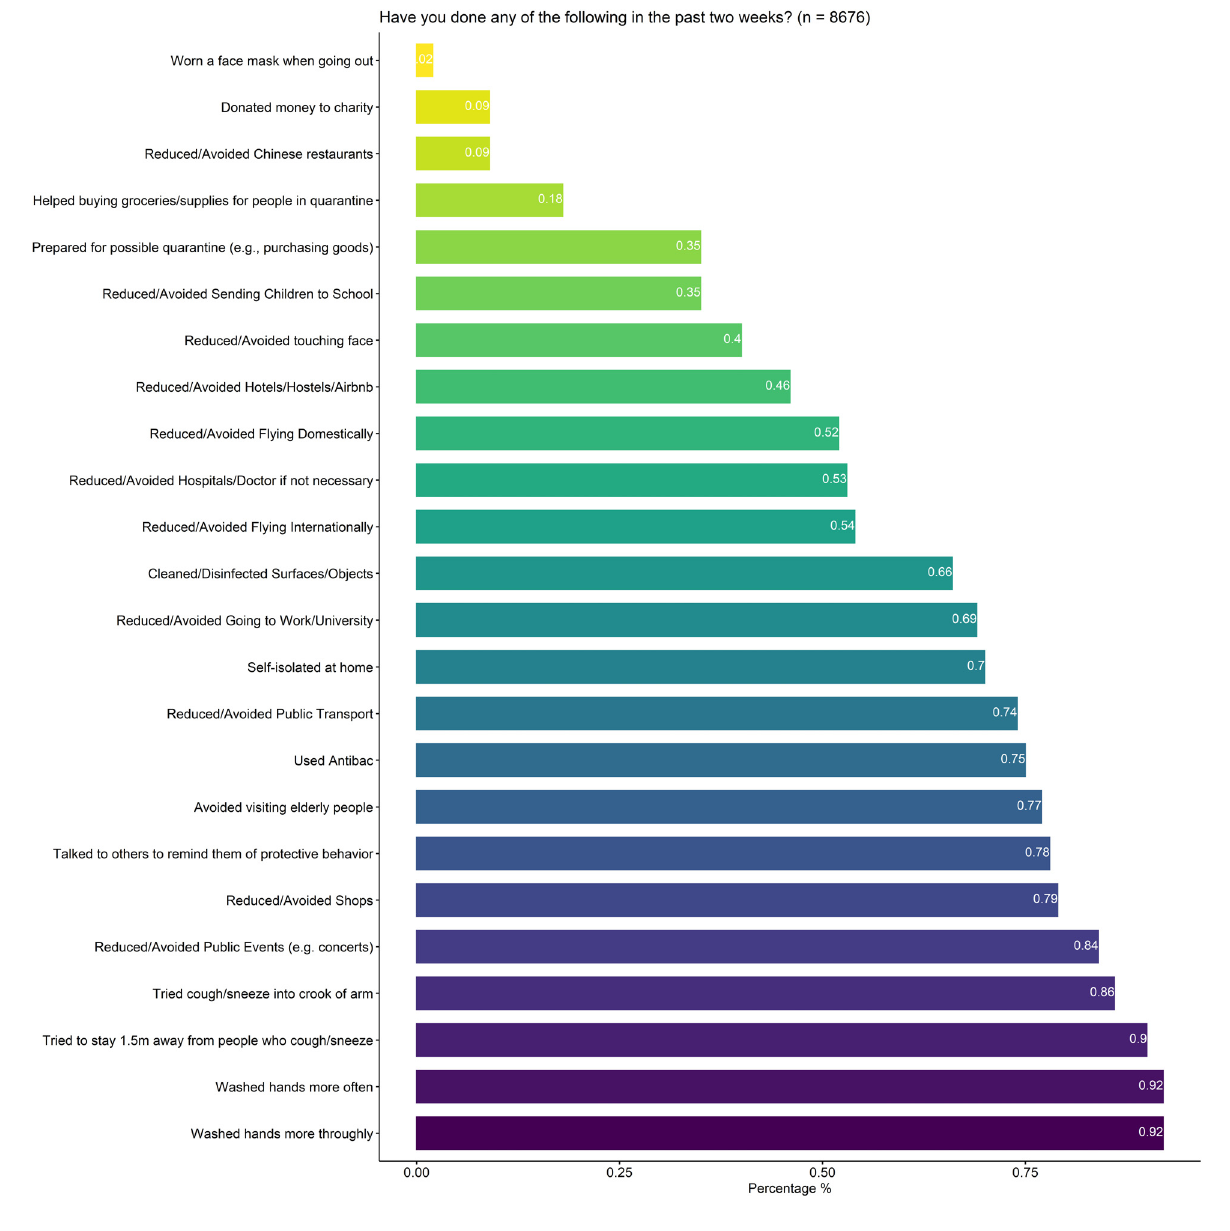
FIGURE 2 | Overview of health/communal-protective behaviors and the percentage of respondents that reported to engage in